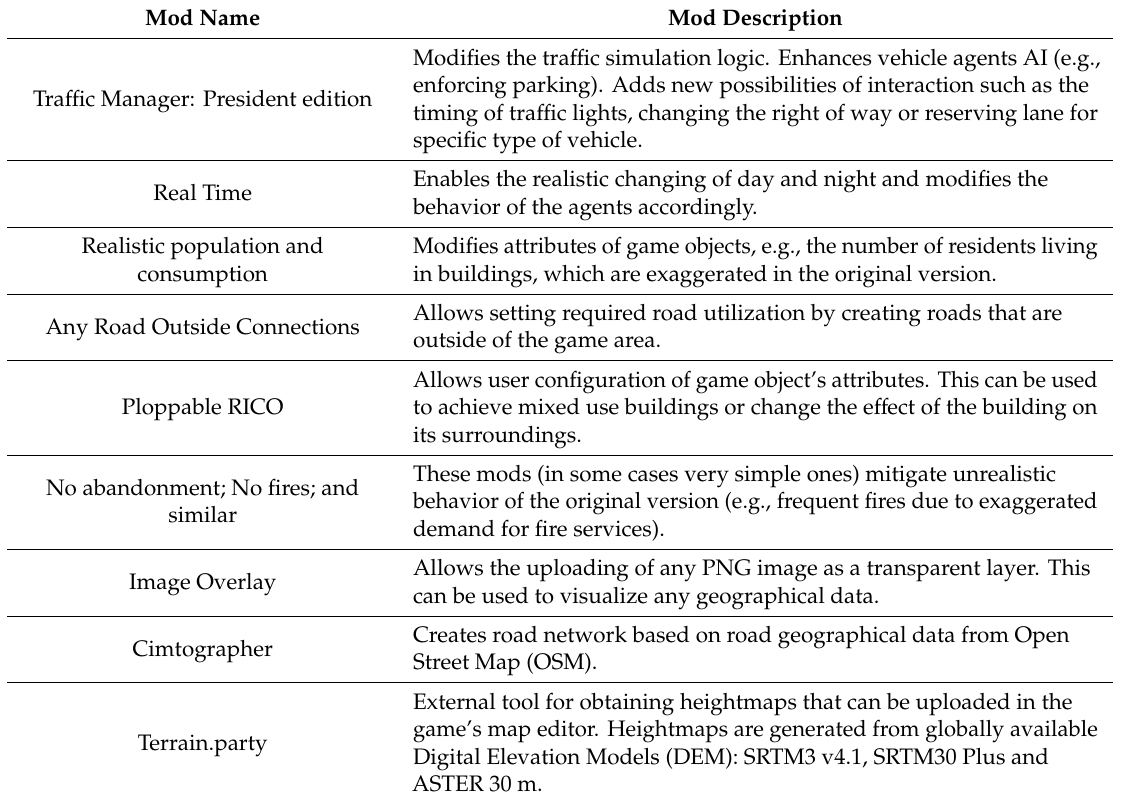
Table 1. Selected Cities: Skylines “urban”